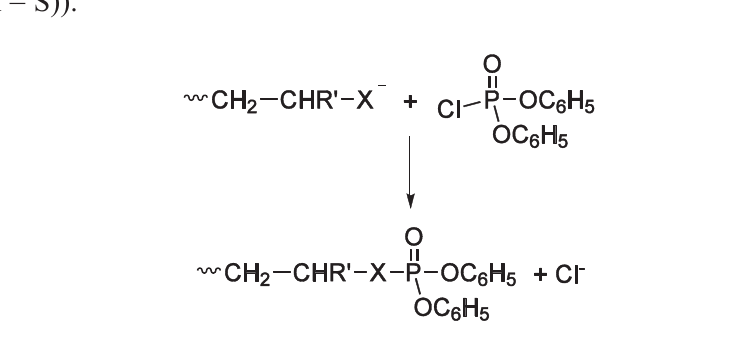
Figure 41. Polymerization short stop with diphenyl chlorophosphate (Alcoholate (X = O) or thiolate (X = S)).